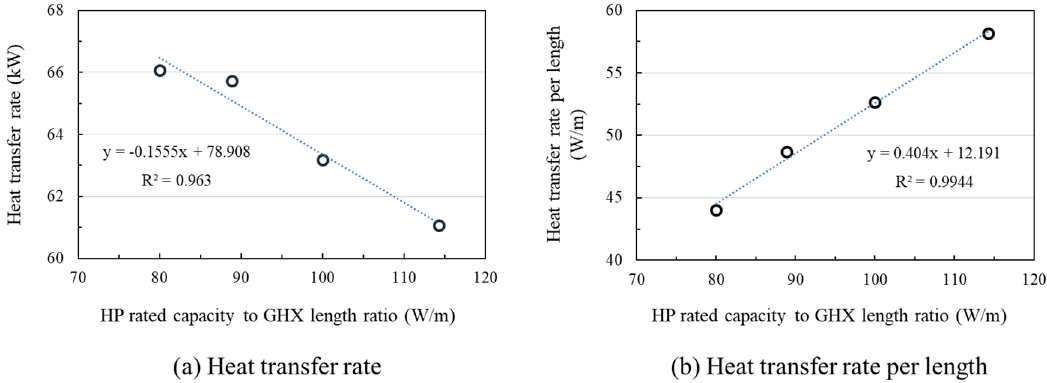
Figure 16. Heat transfer rate change according to the GHEX length. ( a ) Heat transfer rate; ( b ) Heat transfer rate per length.